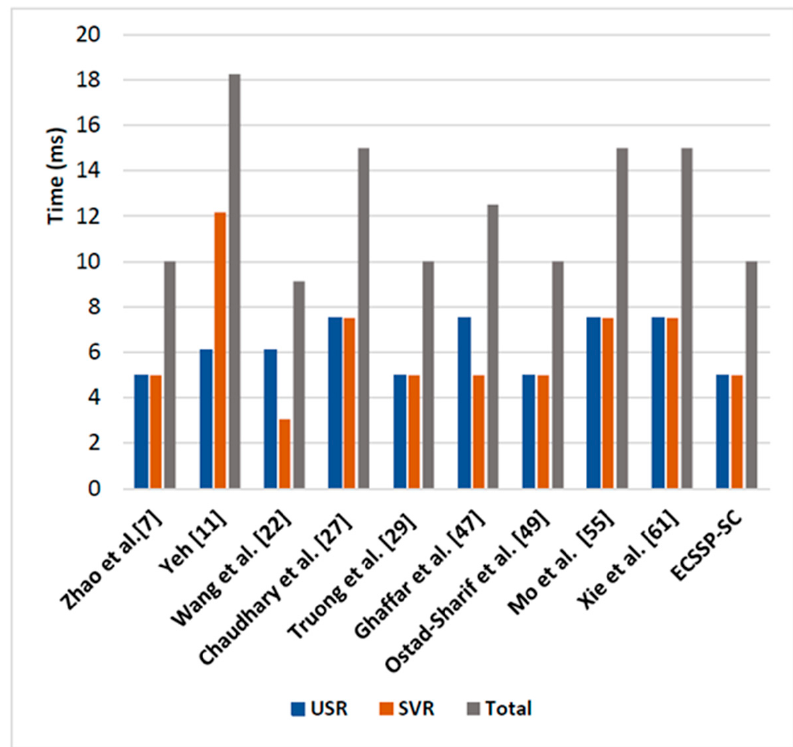
Figure 9. Comparison of the computational time of smart card security protocols.